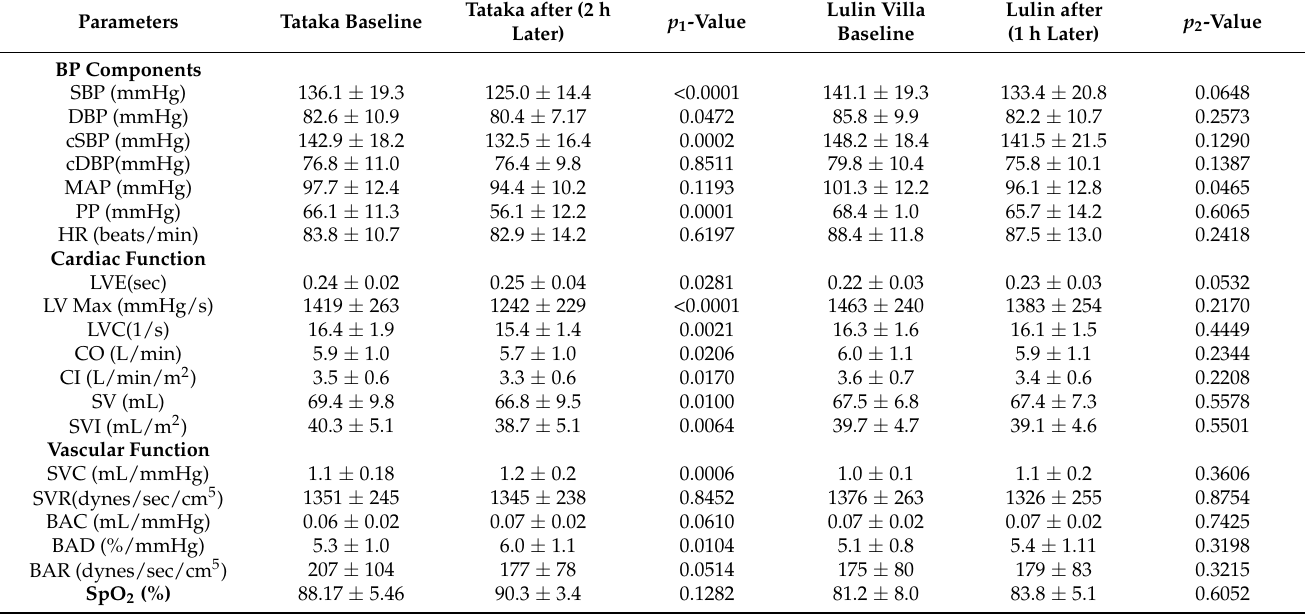
Table 5 presented an adaptation of the cardiovascular hemodynamics in the high- altitude mountain. After staying 2 h at Tataka, BP components such as brachial SBP, DBP, and cSBP among of participants were significantly lower, indicating a rapid physiological adaptation of human body exposure at high altitude. However, there was no significant effect on cardiovascular adaptation at Lulin villa after staying only for 1 h. Vascular func- tions after staying 2 h at Tataka were as follows: the intra-individual comparisons showed CO, and LV dP/dt max decreased significantly from 5.9 L/min, and 1419.1 mmHg/s to 5.7 L/min, and 1242.4 mmHg/s, respectively. The SVC and brachial artery distensibility of participants at Tataka district were higher, revealing statistically significant differences. Table 5. Adaptation of cardiovascular function hemodynamics in high-altitude mountain in winter (N = 22). Tataka after (2 h Lulin Villa Lulin after p 1 -Value p 2 -Value Parameters Tataka Baseline Later) Baseline (1 h Later) BP Components SBP (mmHg) 136.1 ± 19.3